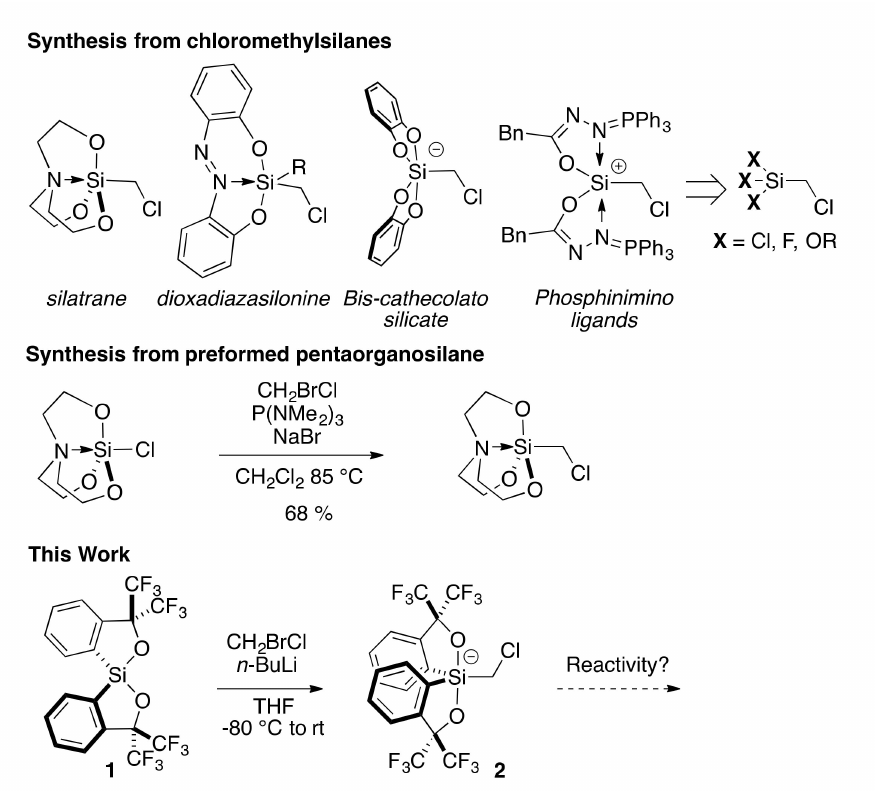
Figure 1. Synthesis of pentacoordinate chloromethylsilane derivatives and presentation of the